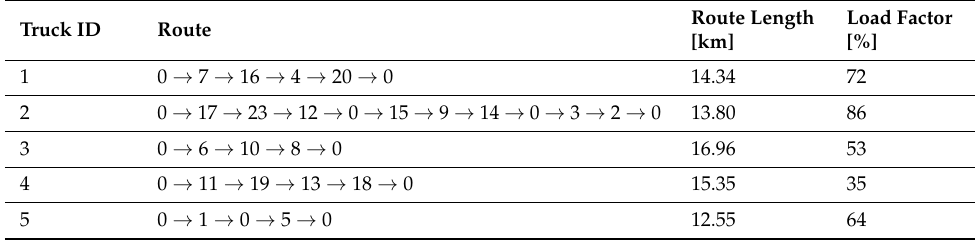
Table 3. Routes and load factors.